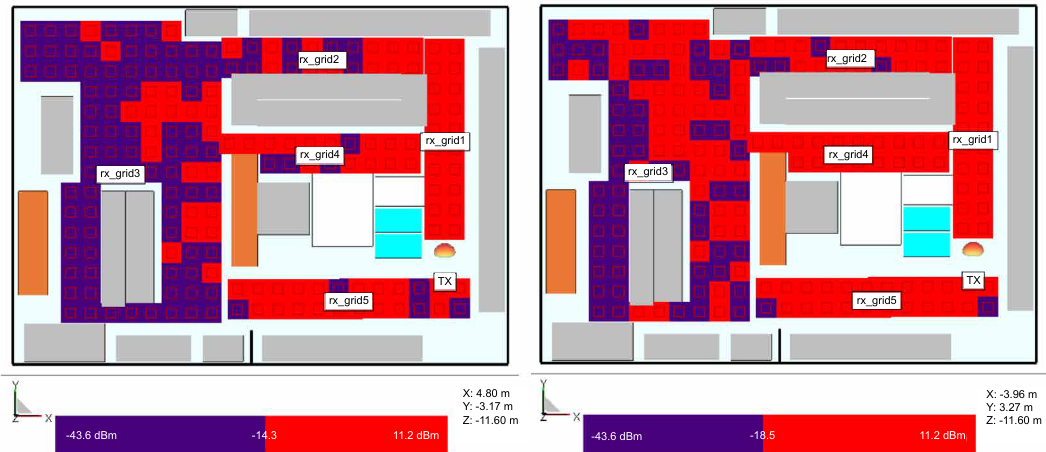
Figure 8. Power distribution for simulation model with empty shelves and standalone tag, Higgs 2 ( left ) and Higgs 4 ( right